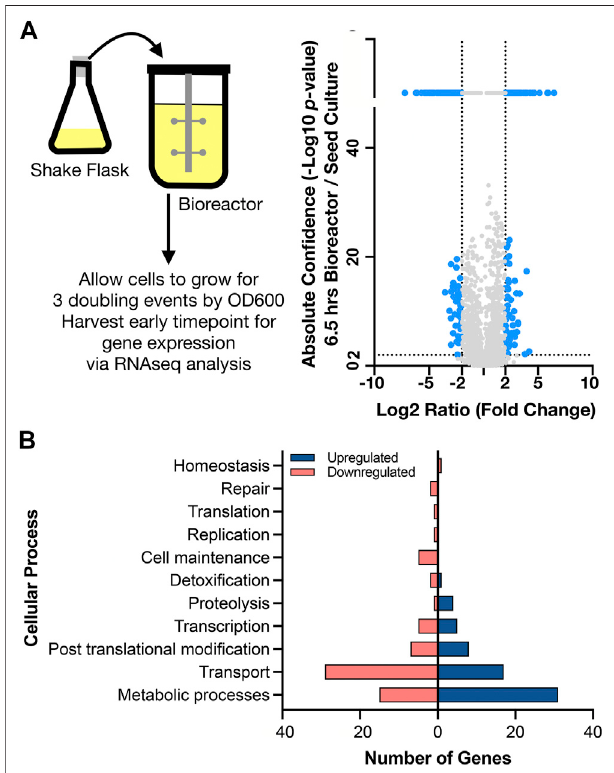
FIGURE 3 | Genome wide expression differences in diverse cellular processes upon shifting to a stirred tank bioreactor, (A) Left side. Schematic showing scale transition from 25 ml seed culture of IP producing C. glutamicum in CGXII media to a stirred tank bioreactor. Right side. Volcano plot comparing differential gene expression (6.5 h post inoculation /shake fl ask)viaRNAseqanalysistoabsolutecon fi dence( p value)ofthesame time points. Fold changes greater than 4 (log 2 (cid:1) 2) and absolute con fi dence values > 2( p < 0.001)areconsideredsigni fi cant.Thethresholdforsigni fi cance is demarcated with dotted lines and the corresponding genes are colored blue. Genes with insigni fi cant differential expression are indicated in grey. Genes with con fi dence values > 40 are placed above the break on the y axis, (B) Analysis of gene classes enriched in the scale transition. Differentially expressed genes from a) were binned into functional categories based on COG annotations and putative function by BLAST alignment. Upregulated genes are indicated in dark blue; downregulated genes are indicated in light